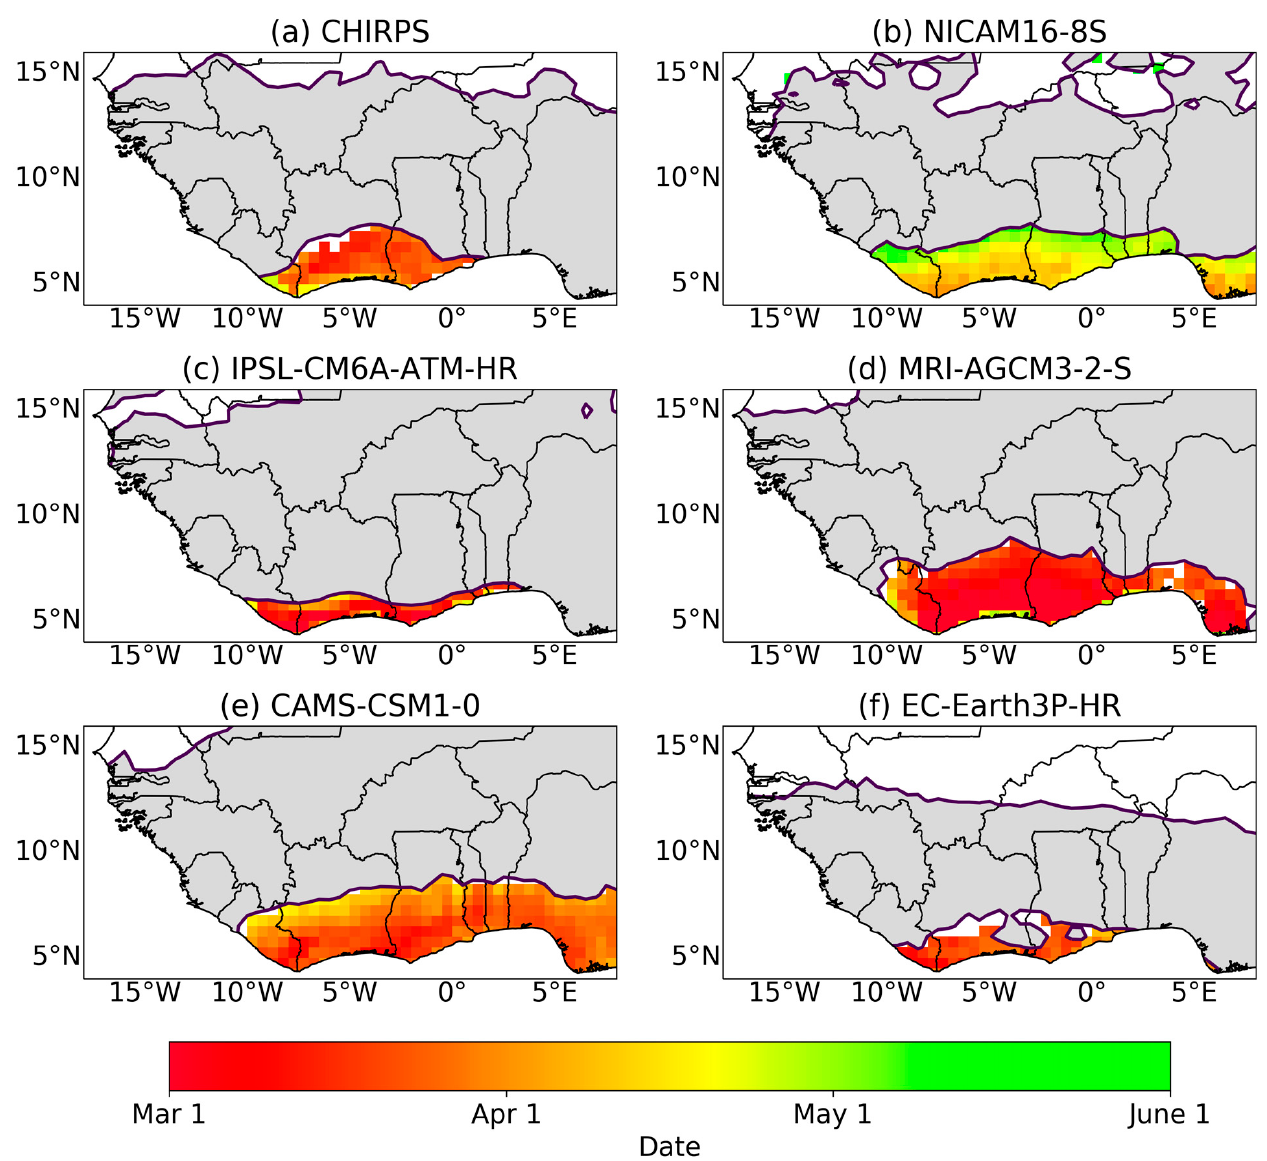
Figure 5. Mean onset date for first (major) rains for all data sets. Dark grey indicates regions with a unimodal regime and white indicates dry regions.